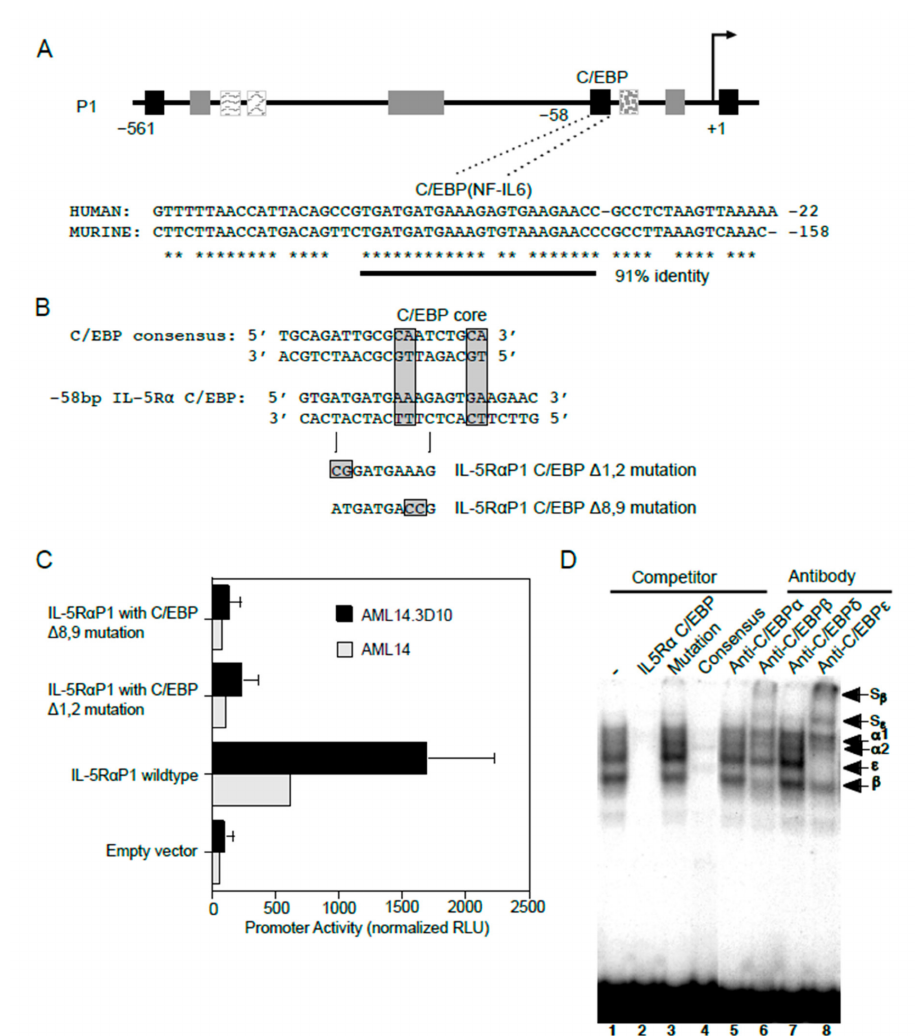
Figure 6. C/EBP functionally binds and regulates IL5RA P1 promoter activity in eosinophilic cell lines. ( A ) Sequence alignment of the human IL5RA P1 and putative murine IL5RA promoters highlights the conserved C/EBP-binding site in both promoters in a region of 91% sequence identity. Conserved bases are indicated by asterisks. ( B ) Alignments of the IL5RA P1 and consensus C/EBP binding sites, and mutations generated in the C/EBP site of the IL-5R α P1-pXP2 promoter construct. ( C ) AML14 eosinophilic myeloblasts and AML14.3D10 eosinophilic myelocytes were transiently transfected with the IL-5R α P1 luciferase promoter reporter construct, containing either the wild-type or mutated C/EBP-binding site, along with a pRL-TK expression vector as an internal control for transfection efficiency. Promoter activities were measured 6 h post-transfection and were normalized by the dual luciferase method. Data are shown as mean ( ± SD) relative light units for three independent experiments. ( D ) AML14.3D10 nuclear extract (3 µ g) was used to demonstrate specificity of various C/EBP protein-DNA complexes. Complex formation was specifically inhibited by a 50-fold molar excess of unlabeled IL-5R α P1 C/EBP (lane 2) and consensus C/EBP site probes (lane 4), but not by a C/EBP site mutation (lane 3). Complex formation was strongly inhibited by antibodies to C/EBP β and C/EBP ε with visible supershifted complexes (S β and S ε , lanes 6 and 8), but not by antibodies to C/EBP α or C/EBP δ (lanes 5 and 7). Specific proteins in protein-DNA complexes are